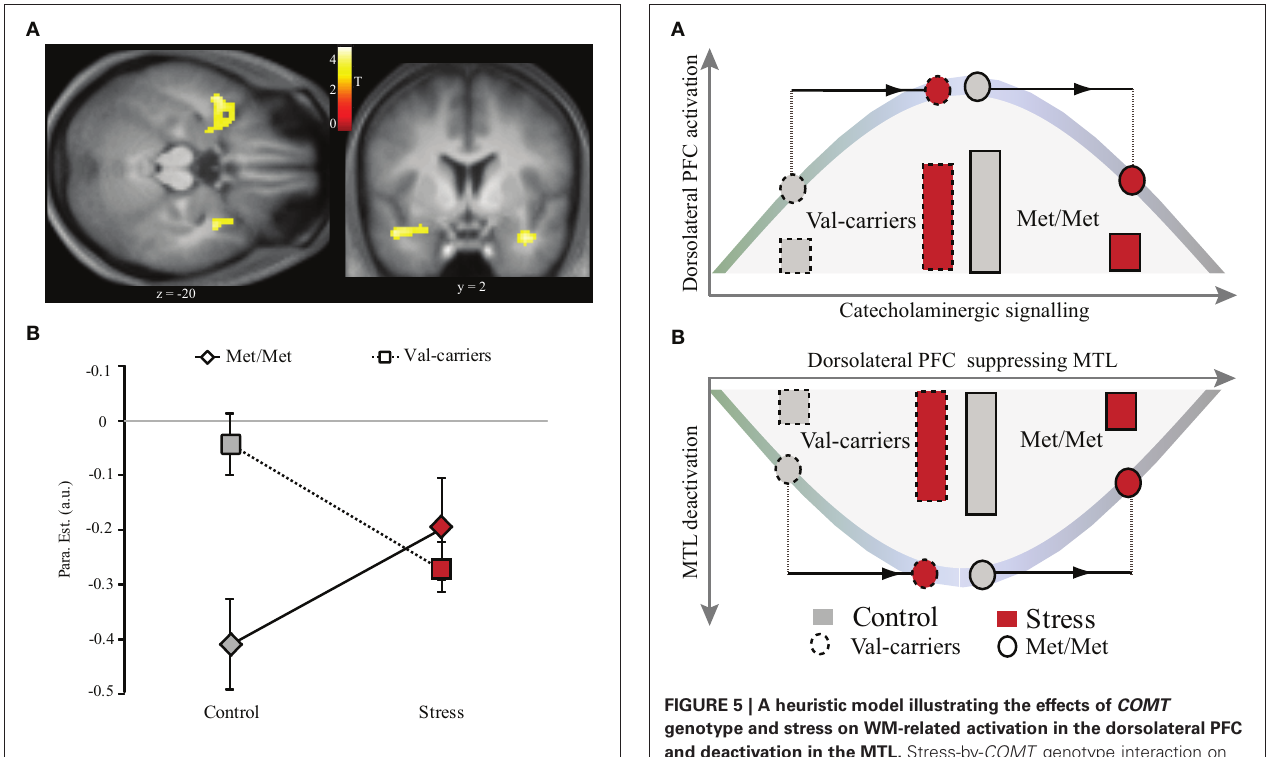
FIGURE 4 | Stress-by-COMT genotype interaction effect on WM-related deactivation in the MTL. (A) Transversal (left panel) and coronal (right panel) view of deactivation in the bilateral anterior MTL showing significant stress-by-COMT genotype interaction effect. Statistical parametric maps are superimposed onto spatially normalized and averaged ( n = 39) high-resolution T1-weighted images (thresholded at p < 0 . 001 uncorrected for visualization purposes). (B) Bar graphs representing parameter estimates of WM-related deactivation under control and stress conditions in Met-homozygotes (Met/Met) and Val-carriers. The data for these bar graphs were extracted illustrating the interaction effect. Note: Control, control condition; MTL, medial temporal lobe; Stress, stress condition; error bars in the graph represent standard error of mean; T, color coded t values obtained from the whole brain analysis.